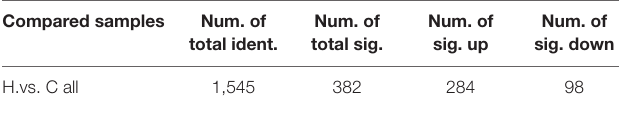
TABLE 5 | Metabolite difference screening results. Compared